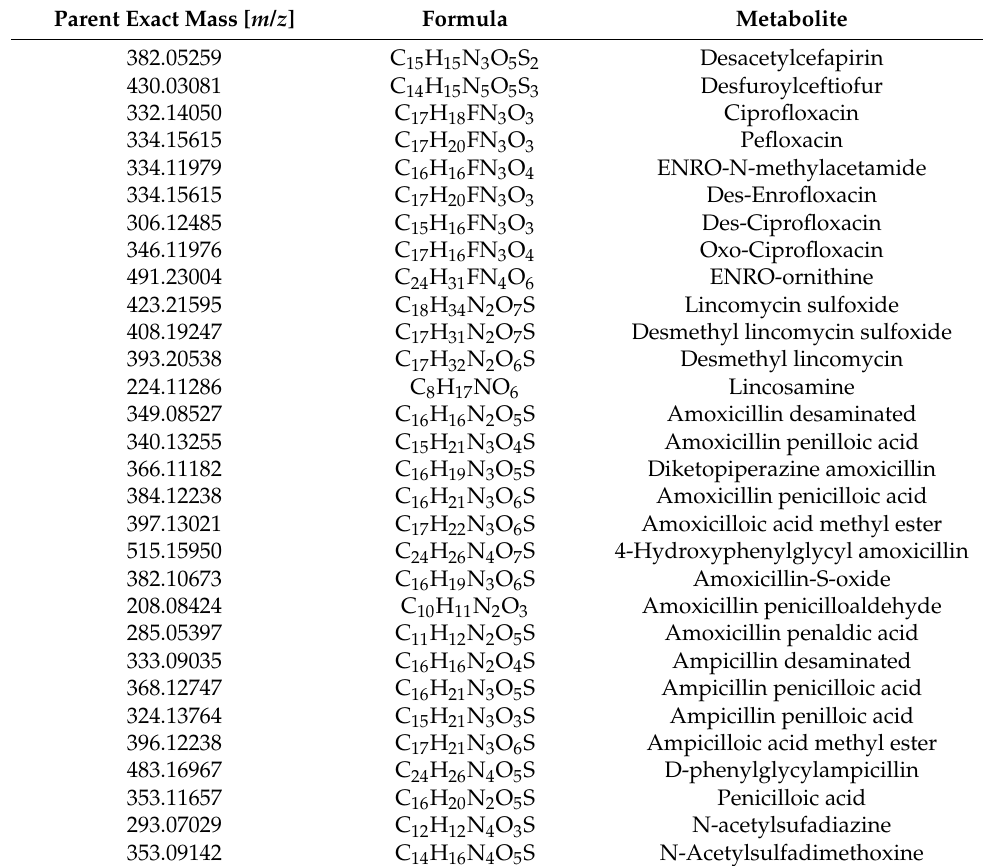
Table 2. Multiclass antimicrobial metabolite list with formula and exact mass in ESI positive ac- quisition mode [ m / z ] used for confirmatory analysis after Compound Discoverer™ approach and literature